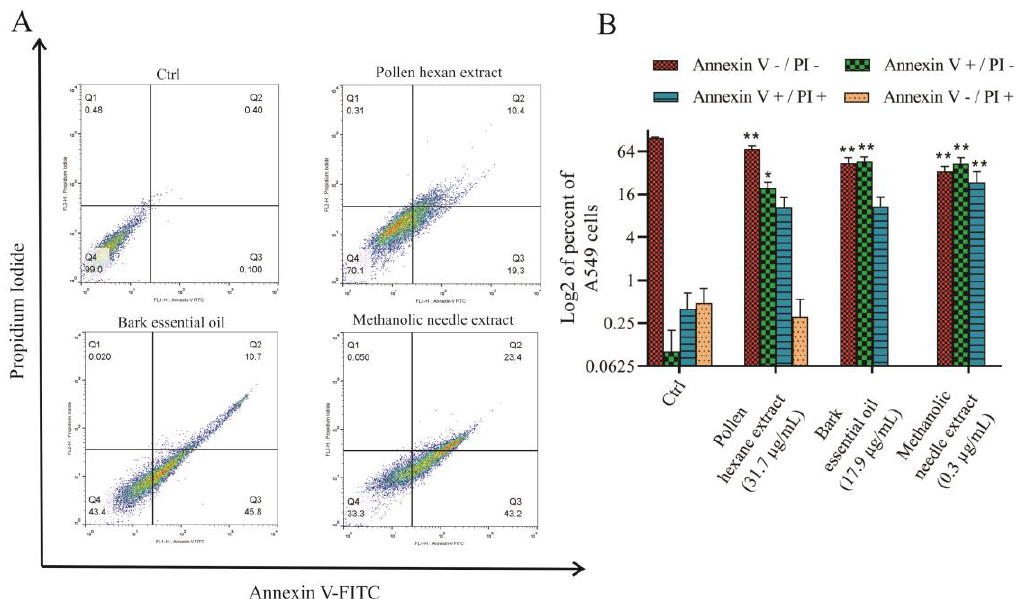
Figure 4. ( A ) Annexin V/propidium iodide (PI) staining was used to identify viable cells: Q4 (Annexin V − , PI − ), early apoptotic cells: Q3 (Annexin V+, PI − ), late apoptotic: Q2 (Annexin V+, PI+), and necrotic cells: Q1 (Annexin V − , PI+). The apoptotic effects of extracts and essential oil were determined by flow cytometry after 48 h in A549 cells, with untreated cells used as a control and cells treated with IC 50 concentrations of pollen hexane extract, bark essential oil, and methanolic needle extract; ( B ) Quantitative results of apoptotic effects evaluated by the Annexin V/FITC assay. Data are expressed as mean ± standard deviation (SD), representative of three independent experiments. * p < 0.05 and ** p < 0.01 vs.